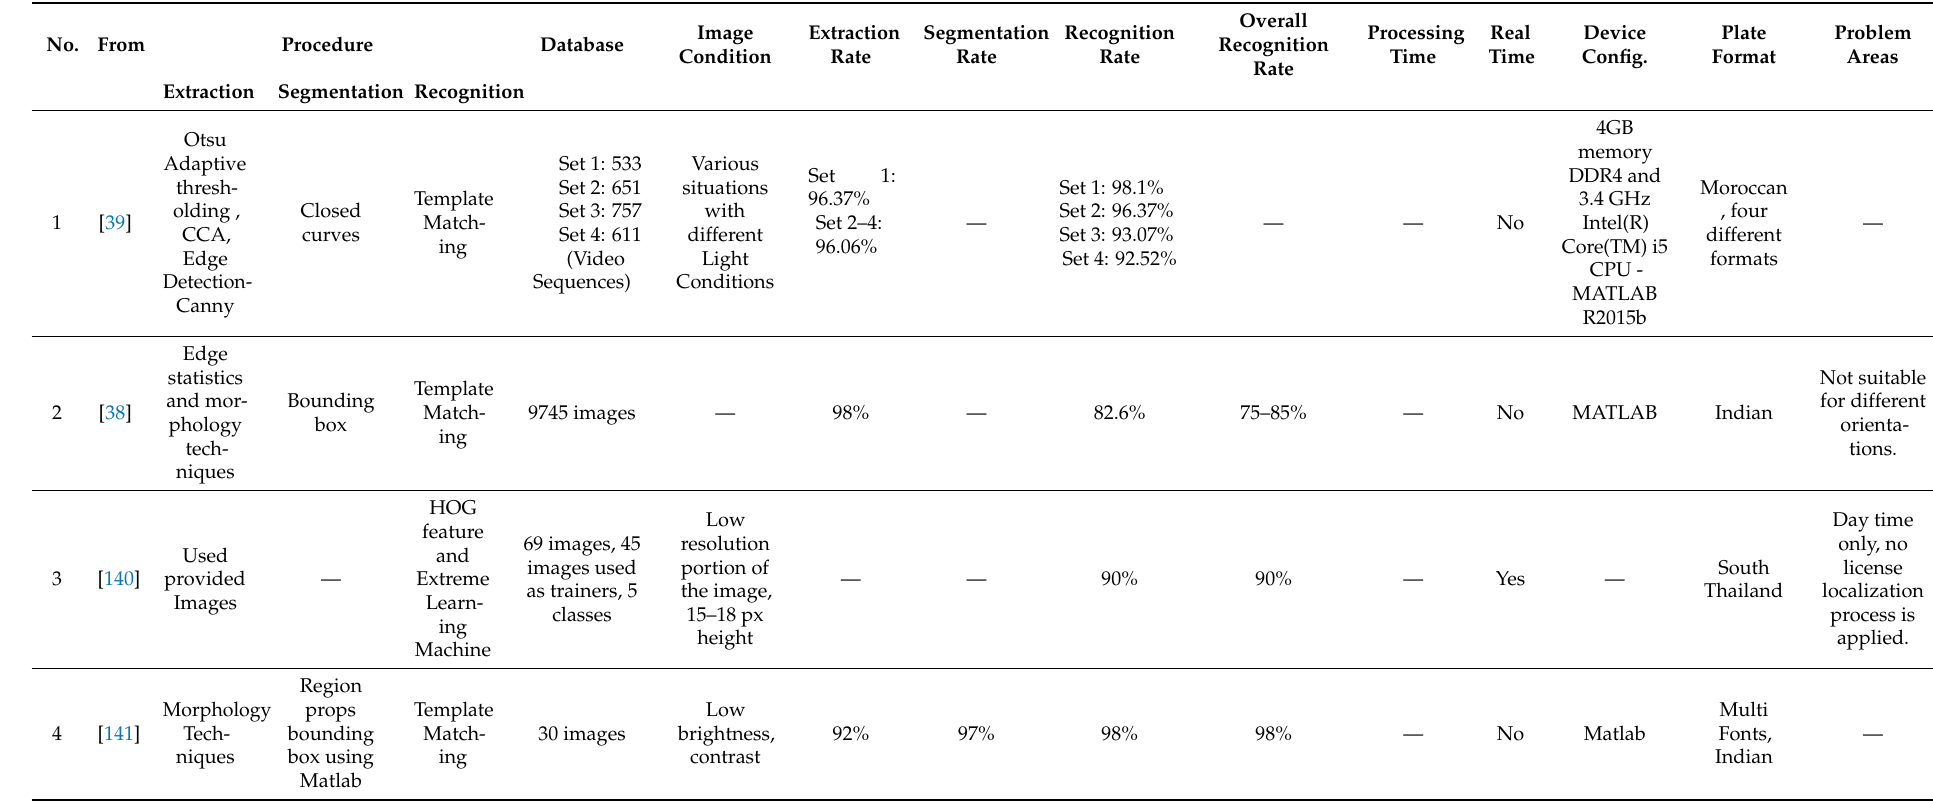
Table 2. Performance Summary of ANPR system